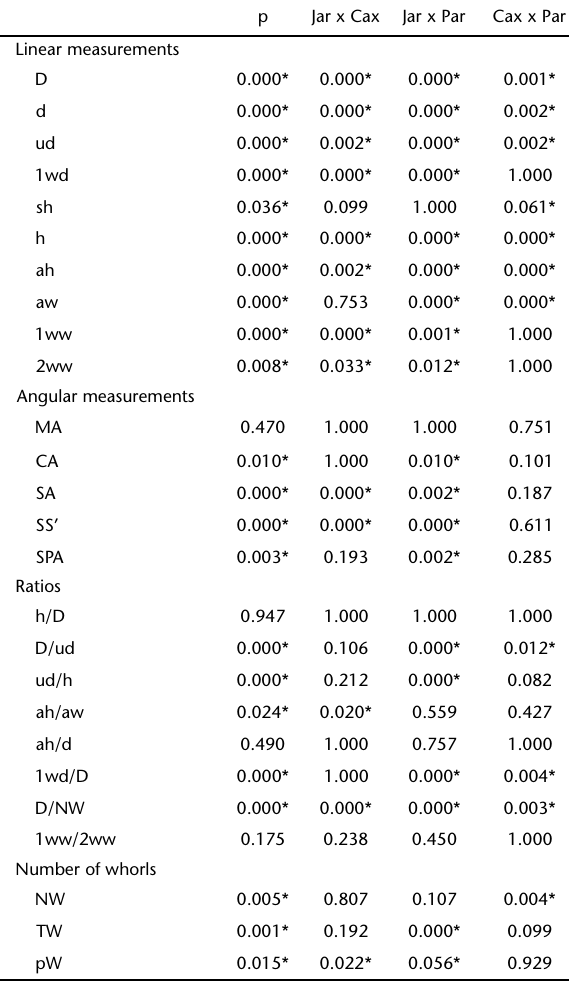
Table III. Results of ANOVA followed by Bonferroni’s multiple comparison test, applied to linear and angular measurements, ratios, and number of whorls of Happiella cf. insularis specimens collected from the Jararaca (Jar), Caxadaço (Cax), and Parnaioca (Par) trails, Ilha Grande. Differences were considered statistically significant* at p (cid:2) 0.05. For abreviations see Table II.